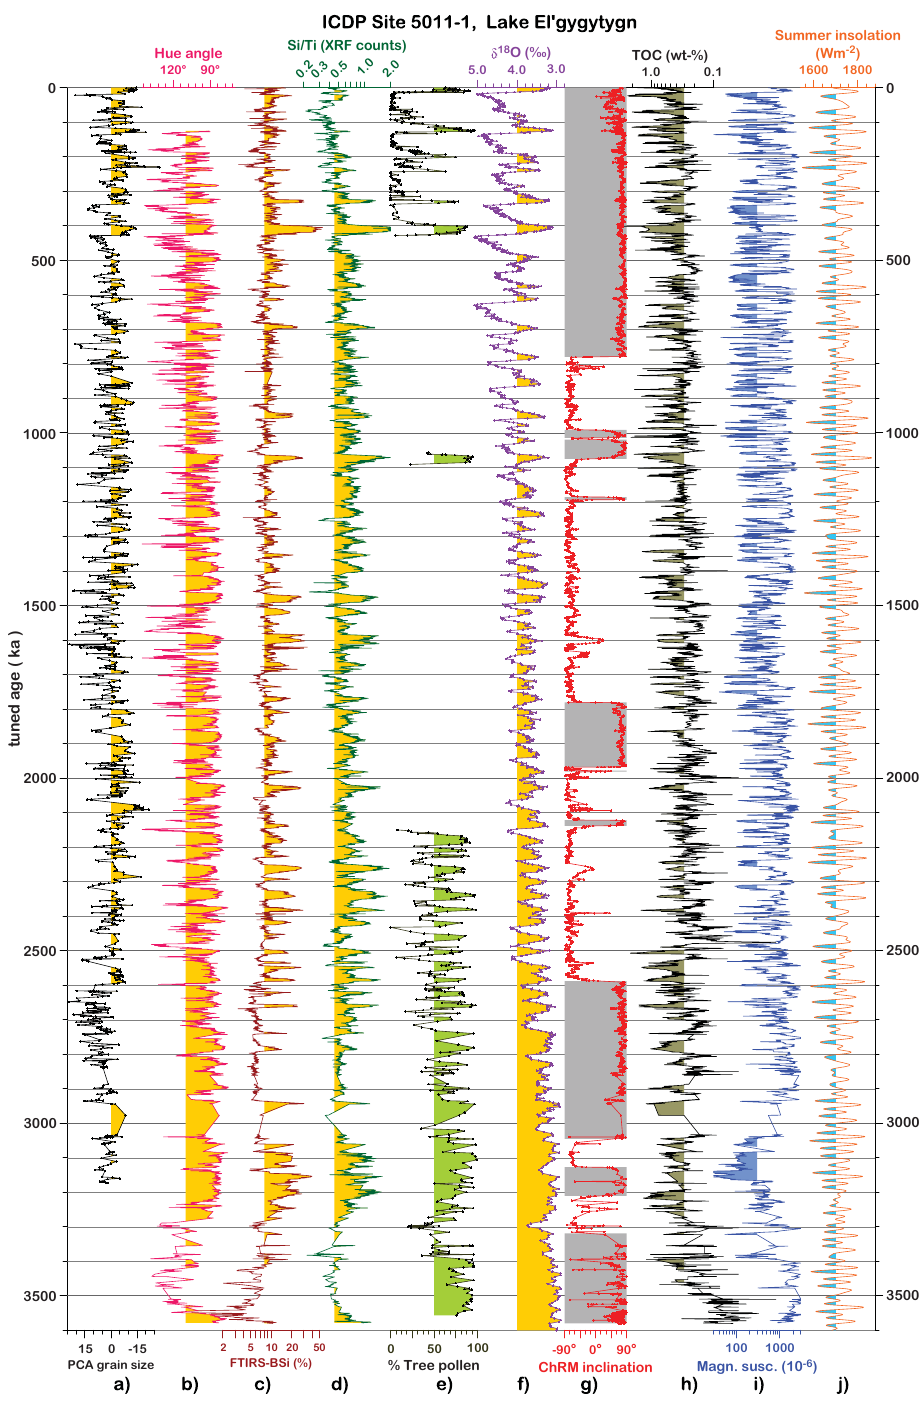
Fig. 6. Chrono-stratigraphic plot of main parameters used for developing the age model of the ICDP Site 5011-1 composite record from Lake El’gygytgyn: (a) grain size data from principle component analysis (PCA), with negative (positive) values representing coarse (fine) grained sediments, (b) , hue angle from photospectrometry (see Fig. 2), (c) biogenic silica from Fourier transform infrared spectroscopy (FTIRS-BSi), (d) Si/Ti ratio from X-ray fluorescence (XRF) scanning, (e) tree and shrub pollen percentages, (f) marine oxygen isotope stack (Lisiecki and Raymo, 2005), (g) inclination of the characteristic remanent magnetisation (ChRM), with grey (white) indication normal (reversed) polarity, (h) total organic carbon (TOC), (i) magnetic susceptibility, and (j) the cumulative Northern Hemisphere summer insolation (May to August), according to orbital solutions provided by (Laskar et al.,